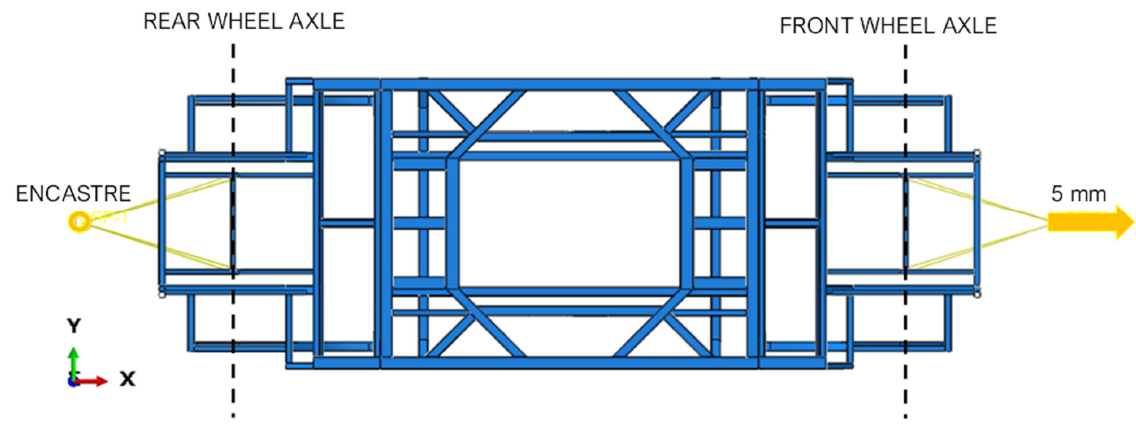
Figure 6. Finite Element